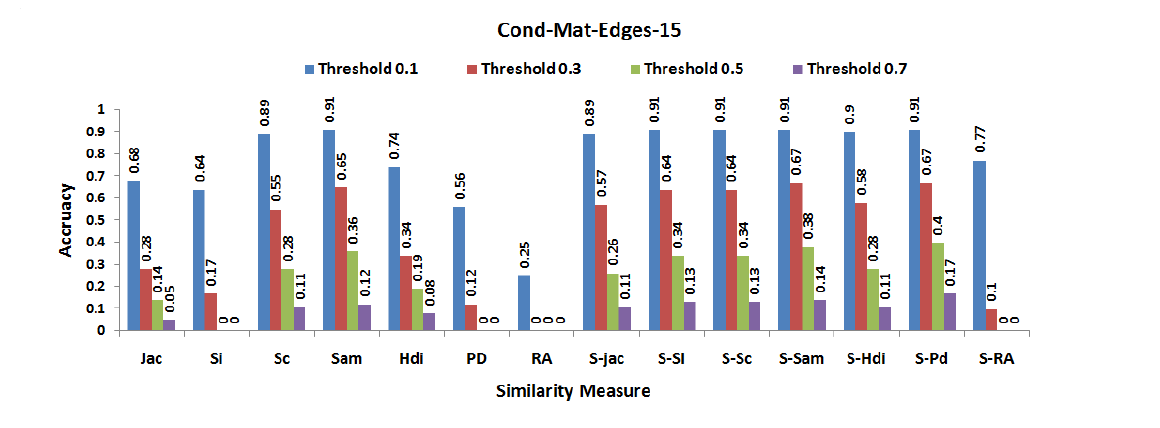
Figure 6. Prediction Results using CondMat Dataset with 10% Edges